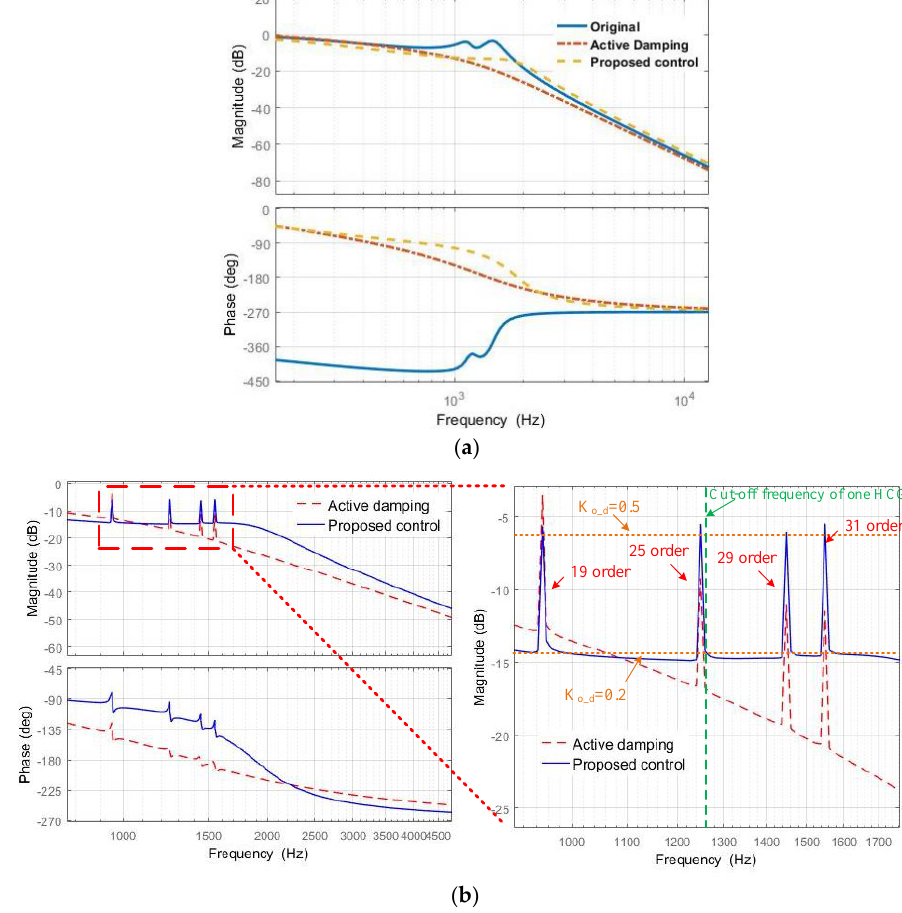
Figure 17. Bode diagram of 3-parallel HCGIs under two methods. ( a ) Fundamental; ( b ) With high-frequency harmonics.